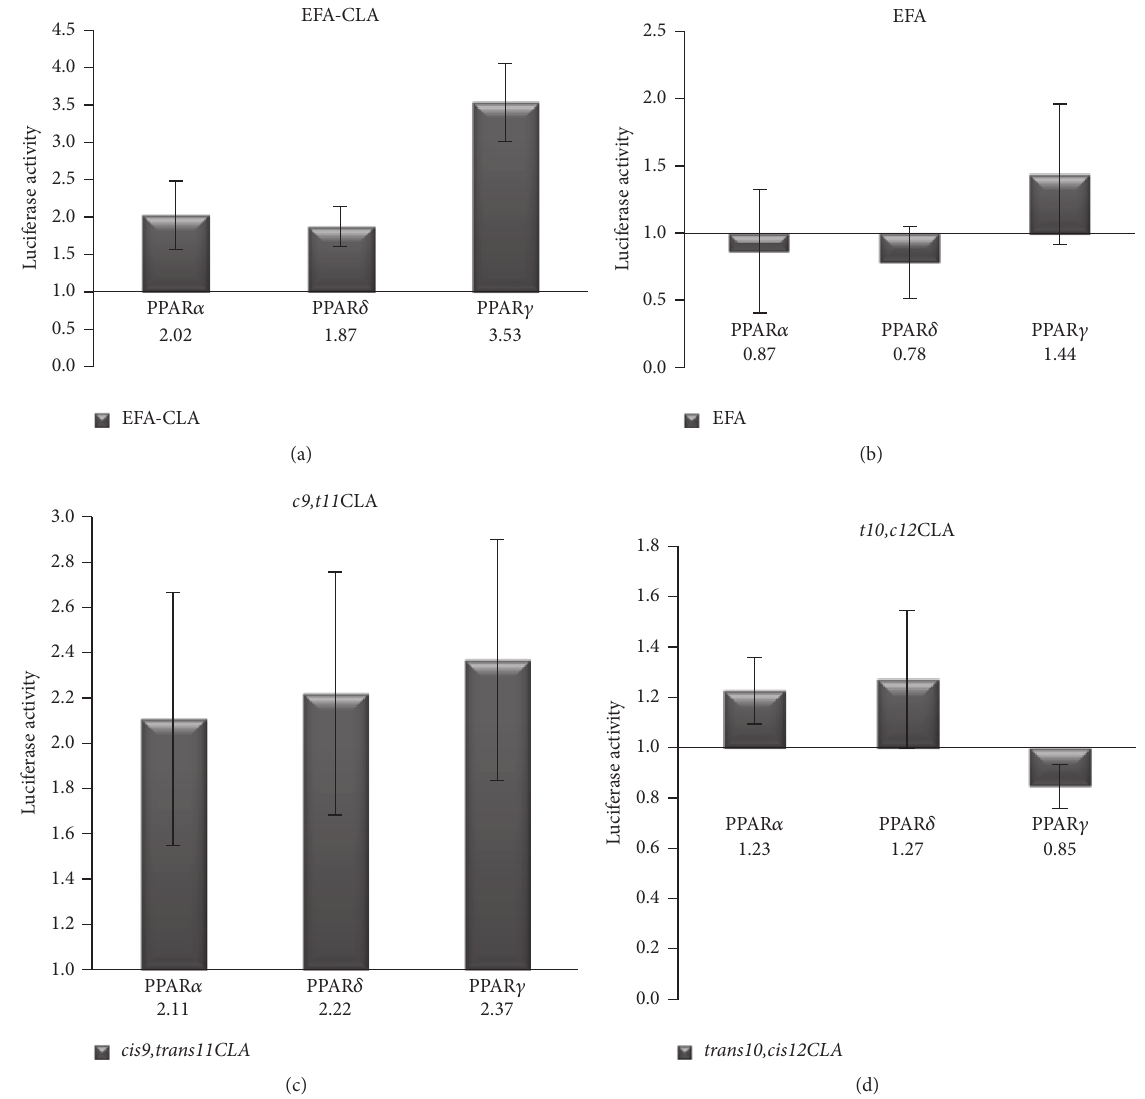
Figure 4: Selective effect of FA on PPARs expressed as fold difference versus control (100%), based on data from Figure 3. Values are expressed as means ± SEM for the 𝑁 ≥ 12